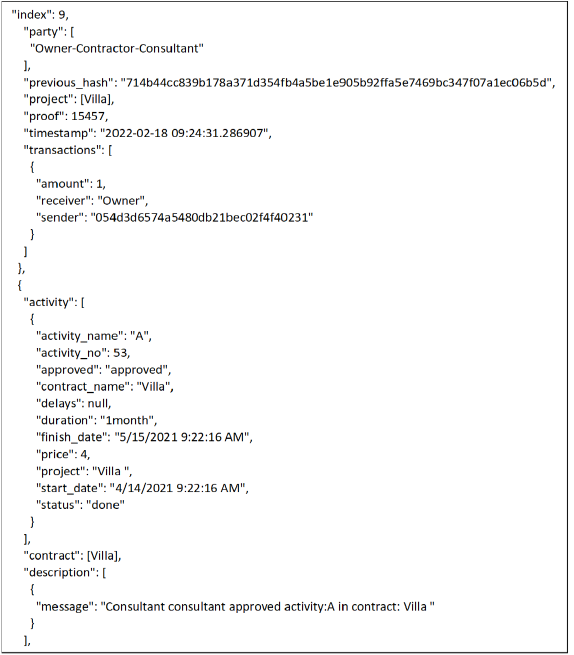
Figure 10. A sample block for approving the first milestone inside the blockchain.